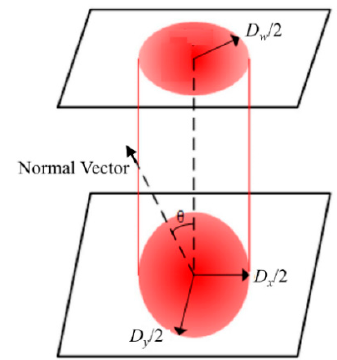
Figure 5. The projected spot size changing with the incident angle. θ is the angle between the laser light and the normal vector of the sample surface.